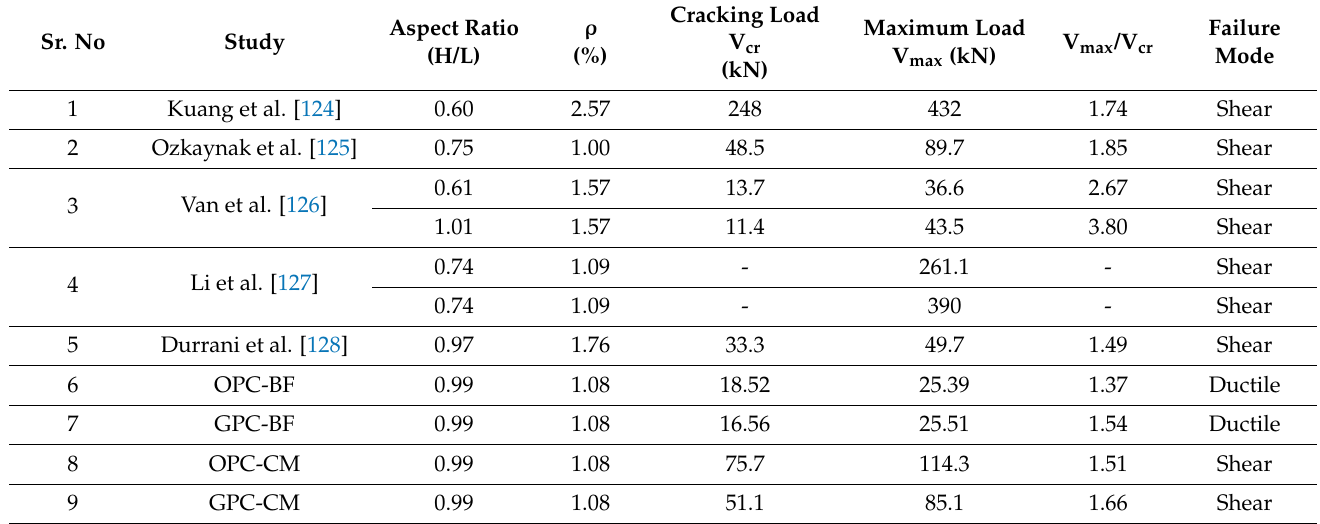
Table 7. Comparison of the present study with past studies on infill masonry.